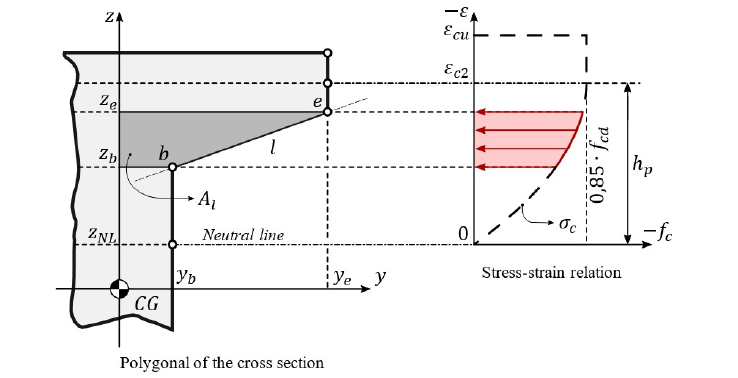
Figure 5. Subdivision of the cross section into